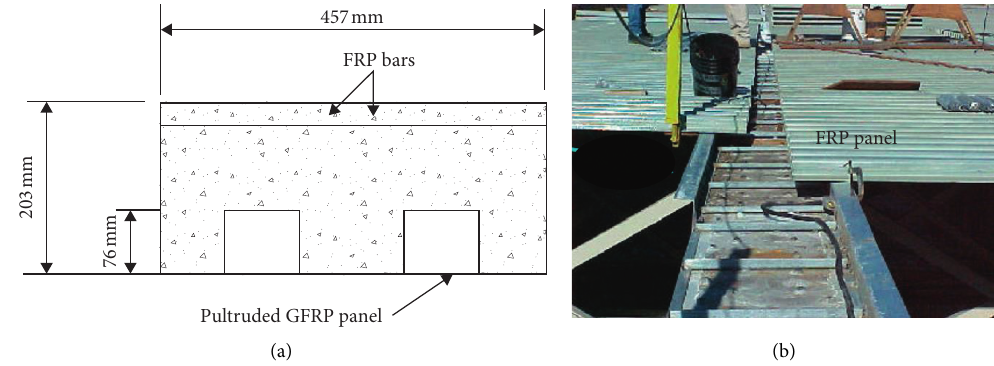
Figure 14: The hybrid deck system applied by Ohio DOT. (a) One of hybrid deck systems. (b) FRP panels attached to steel girders.